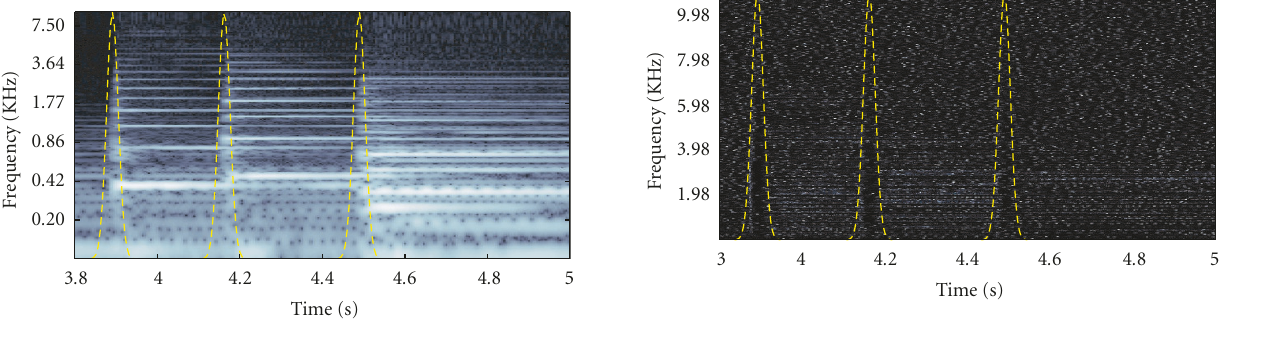
Figure 7: The phase plane of the STFT of Figure 4, transformed according to (2). The dashed line represents the labeled onsets po- sitions. In this representation, the onset patterns are hard to